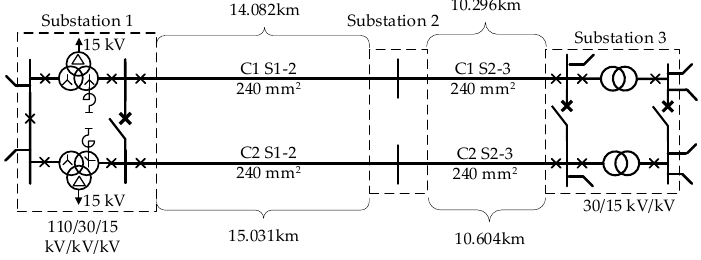
Figure 3. Normal working system of cable lines; C1 S1–2—Circuit 1, Section 1–2, etc. [16].